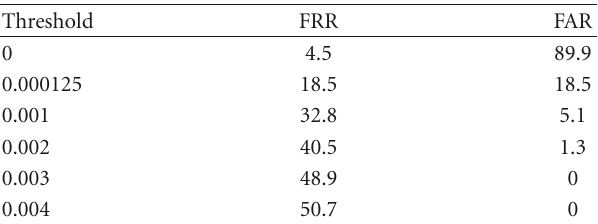
Table 4: The summarized threshold for distinguishing the clients and impostors.